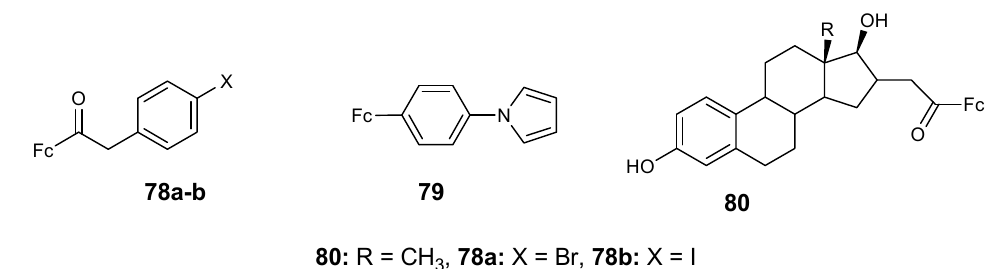
Figure 27. Chemical structures of ferrocene – carboxylate derivatives ( 76 – 80 ).